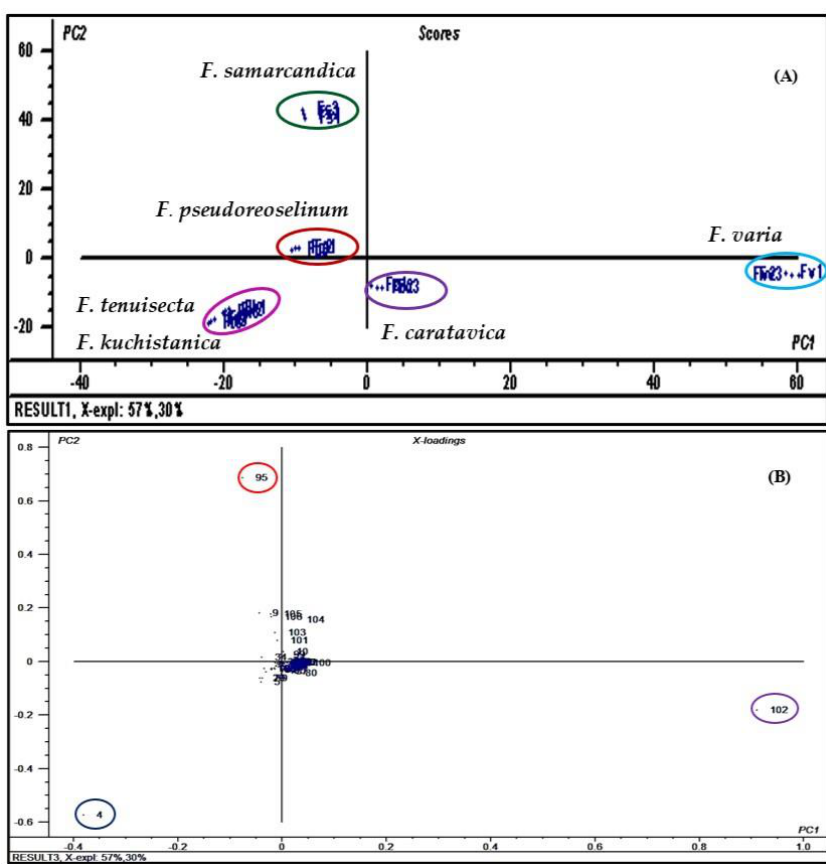
Figure 4. Score plot ( A ) and loading plot ( B ) of GC data obtained from F. caratavica , F. kuchistanica , F. pseudoreoselinum , F. samarcandica , F. tenuisecta and F. varia essential oil analyses using principal component analysis (PCA). In the loading plot, compounds are given numbers as in Table 1 where the major discriminatory signals are α -pinene (4), palmitic acid (95) and 10,13-docosadienoic acid methyl ester (102) . Table 2. The Pearson correlation matrix of the essential oils content of di ff erent samples. Fc Fk Fp Fs Ft